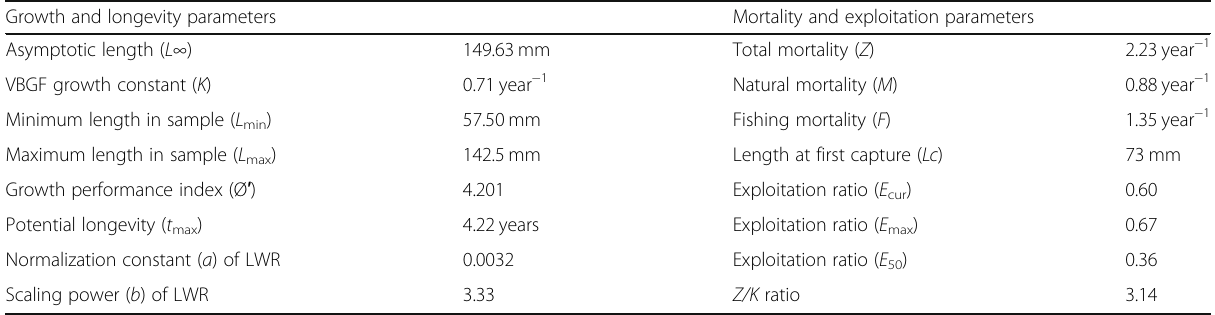
Table 2 Growth, mortality, and exploitation parameters of Pachypterus khavalchor from the Panchaganga River, Maharshtra, India Growth and longevity parameters